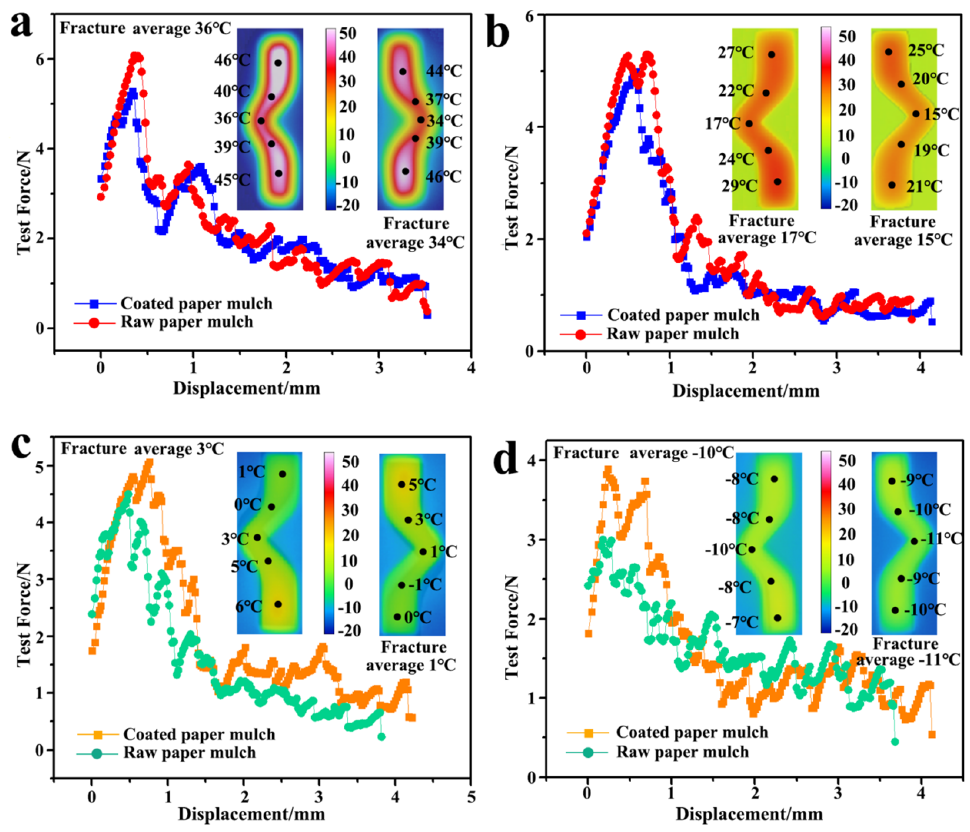
Figure 15. ( a ) High temperature tear graph, ( b ) Normal temperature tear graph, ( c ) Low temperature tear graph, ( d ) Ultra ‐ low temperature tear graph.